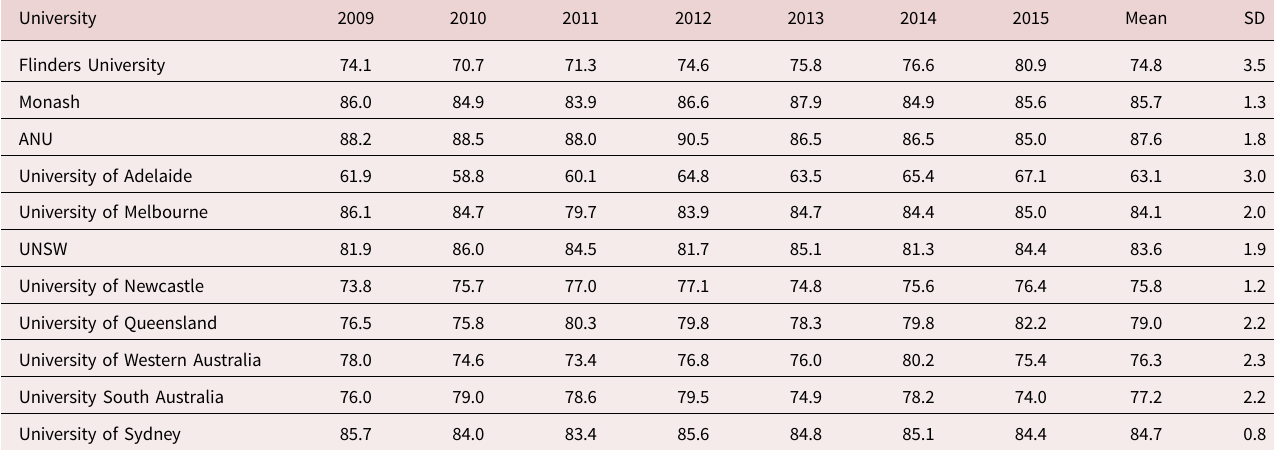
Table 3. Success rates (%) by university ( n =11) by year 2009 –